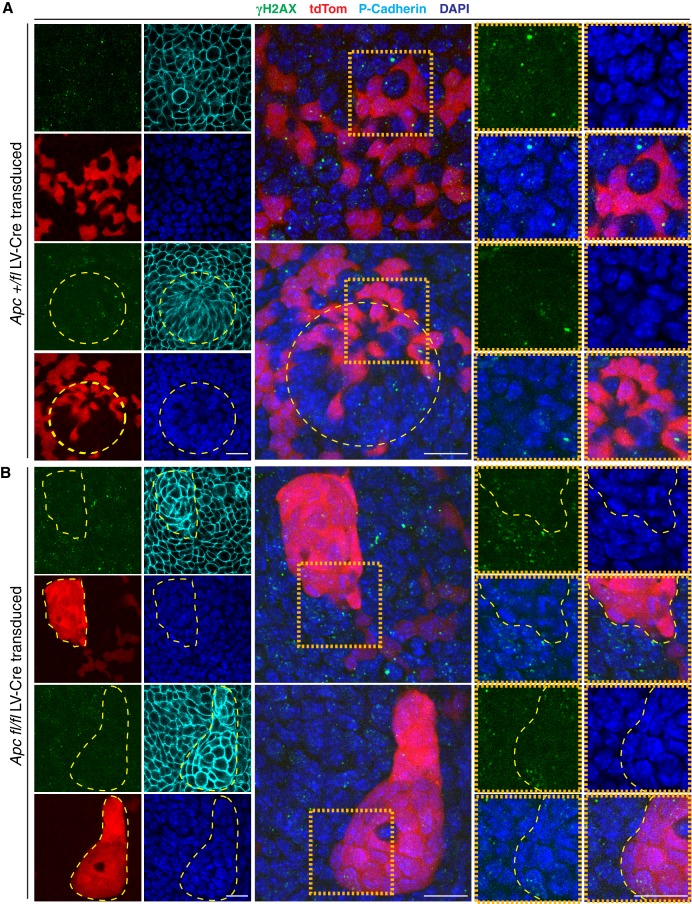
Apc-null clusters do not present signs of DNA double strand breaks.(A–B) Immunofluorescence detection of γH2AX in developing epidermis of (A) Apc fl/+ and (B) Apc fl/fl Rosa26-lox-stop-lox-tdTOM embryos were transduced at E9.5 with lentivirus harboring a Cre recombinase (Pgk-Cre-mRFP) and analyzed at E14.5. Circular yellow dashed line outlines a placode. Orange insets highlight transduced (tdTOM+) versus non-transduced epithelia. Yellow dashed lines contour Apc-null clusters. Scale bar, 20 μm for all frames.